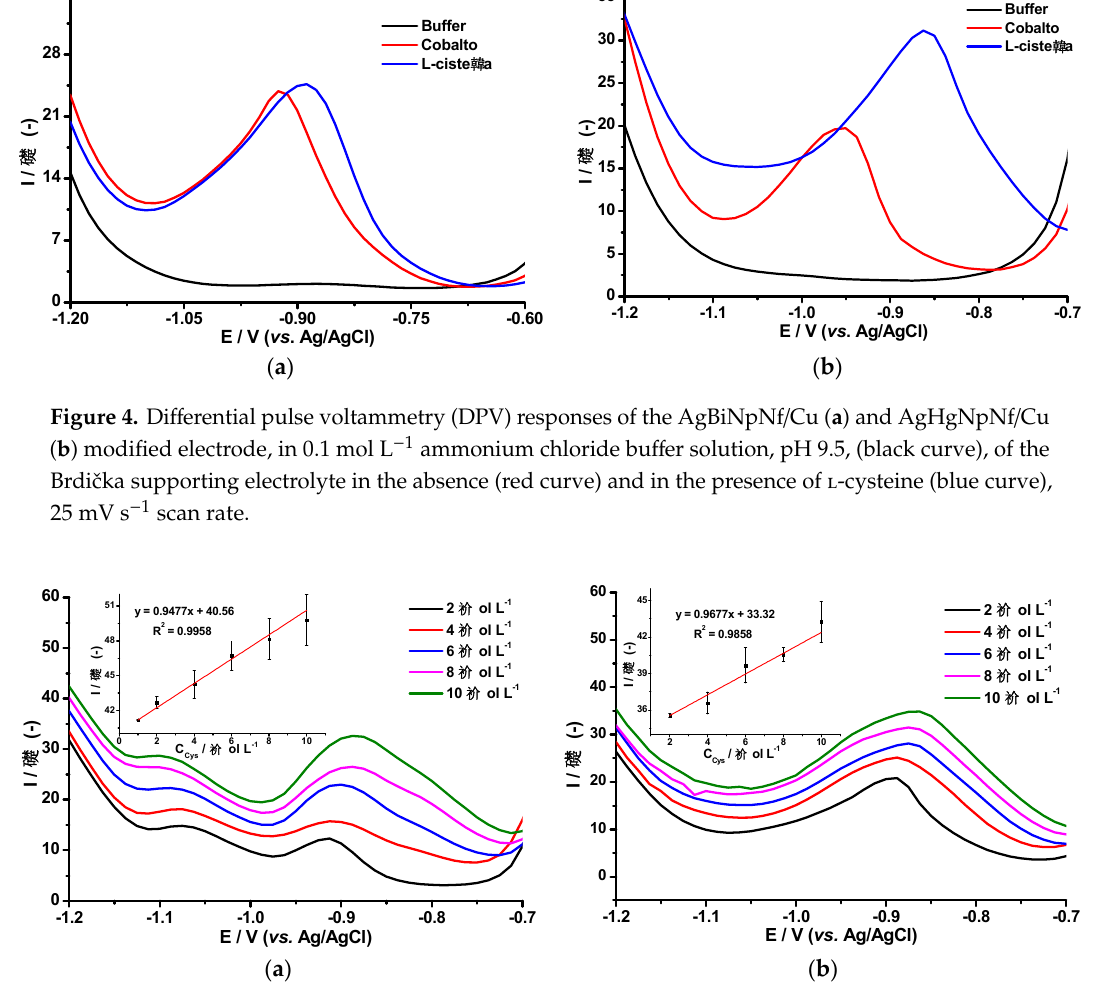
Figure 4. Differential pulse voltammetry (DPV) responses of the AgBiNpNf/Cu ( a ) and AgHgNpNf/Cu ( b ) modified electrode, in 0.1 mol L − 1 ammonium chloride buffer solution, pH 9.5, (black curve), of the Brdi č ka supporting electrolyte in the absence (red curve) and in the presence of L -cysteine (blue curve), 25 mV s − 1 scan rate.